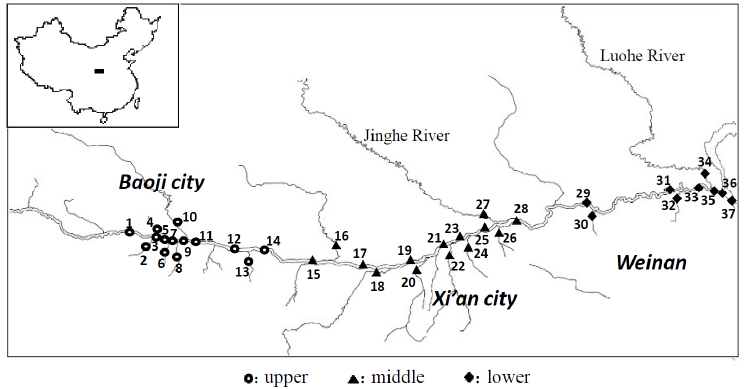
Figure 1. The study area and sampling locations in the Weihe River,